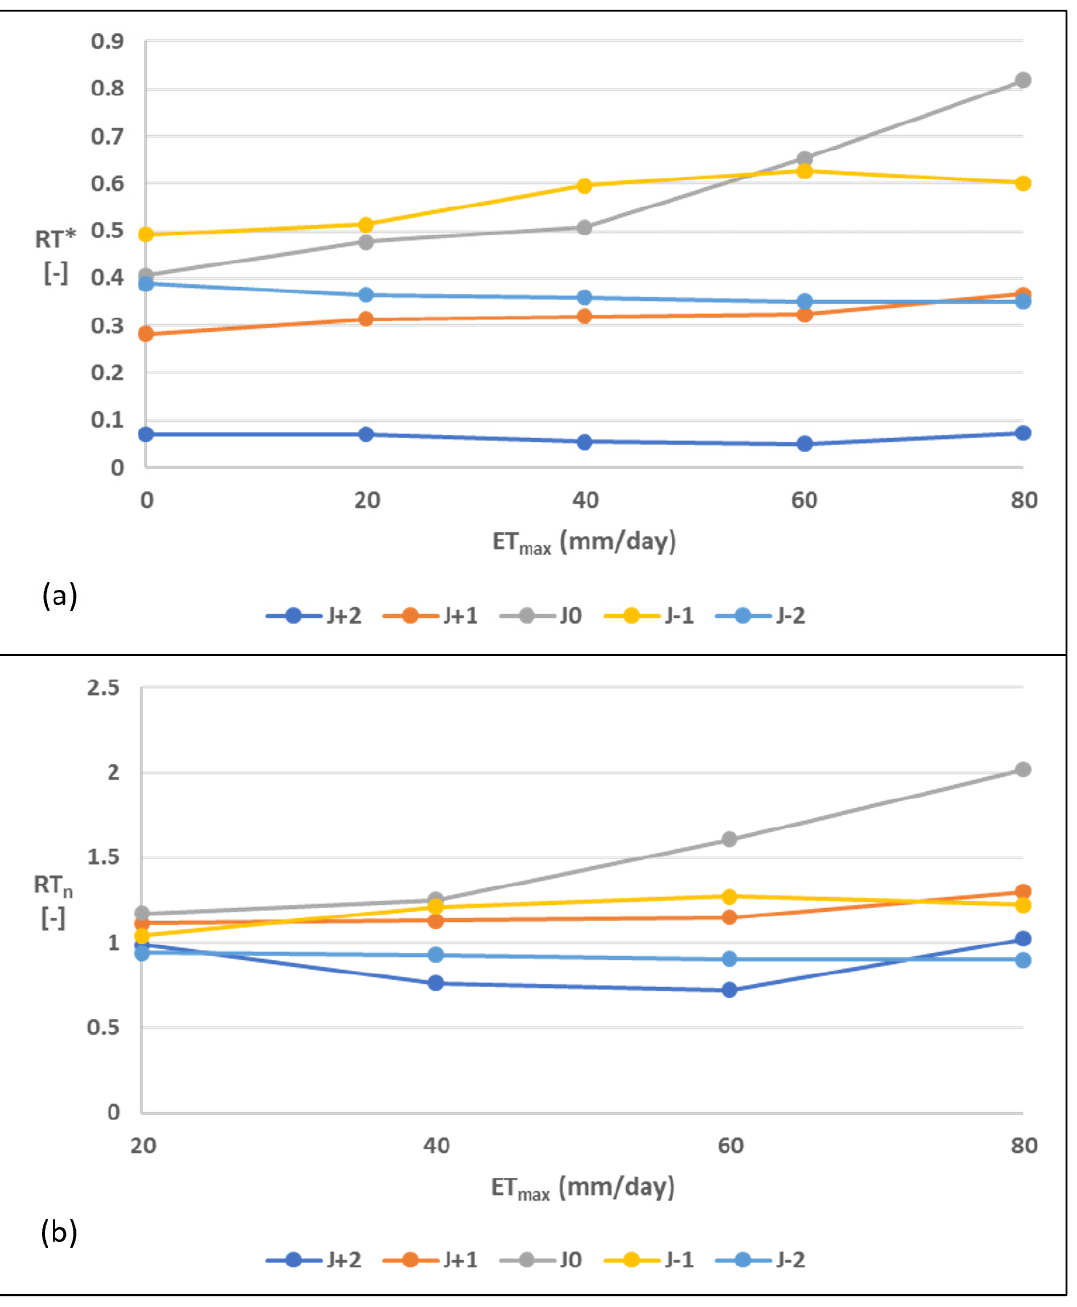
Figure 7. ( a ) Median dimensionless RT ( RT *) for all regional groundwater flux ( J y/x ; positive for gaining, negative for losing) scenarios as a function of ET max . ( b ) Median RT * values from active ET scenarios, normalized to their respective ET0 simulations.